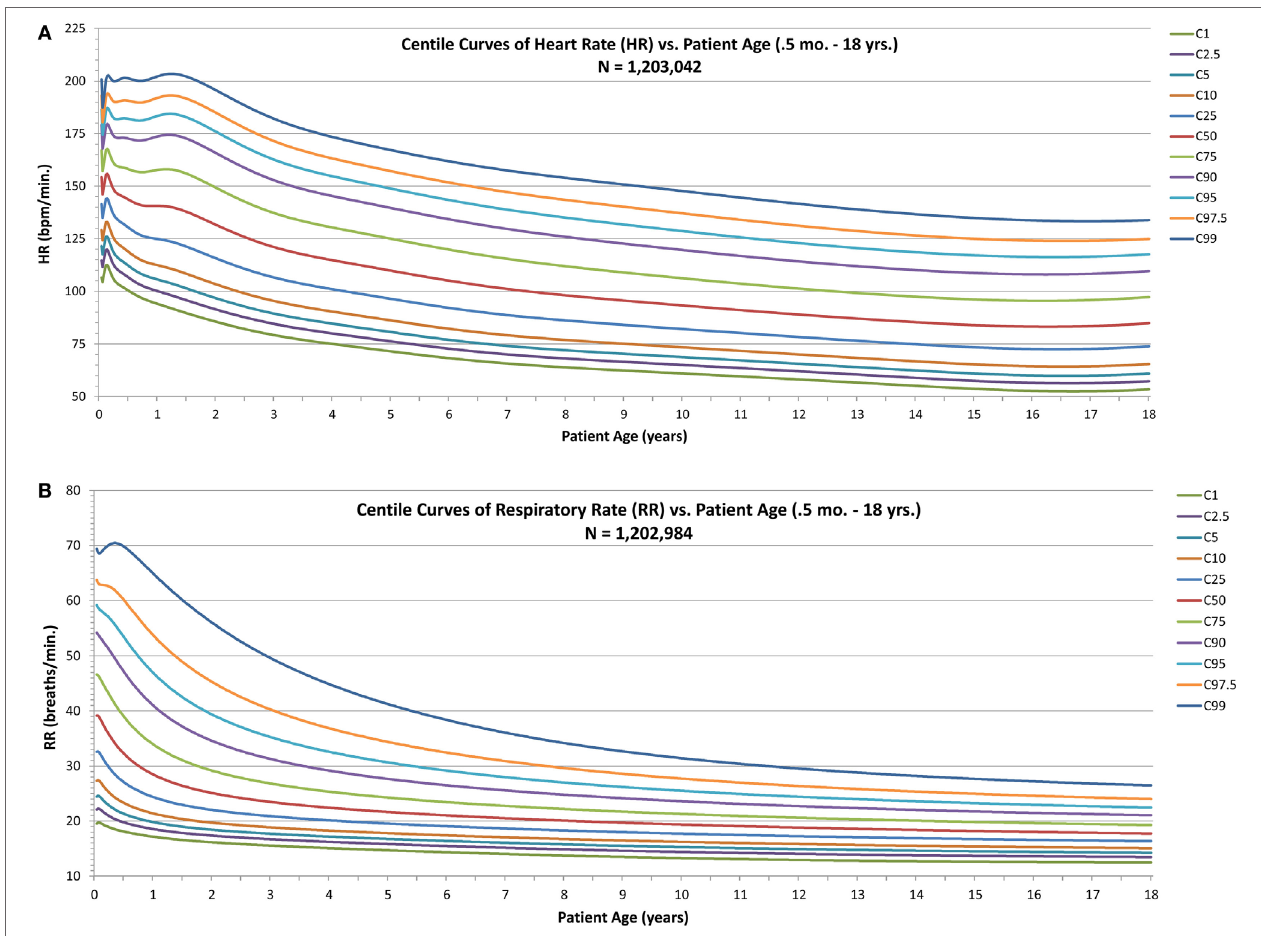
FigUre 2 | Modeled centile curves for pediatric vital sign metrics. (a) The centiles from the first centile (C1) to the 99th centile (C99) for heart rate (HR) by age and (B) the respiratory rate (RR) centiles.